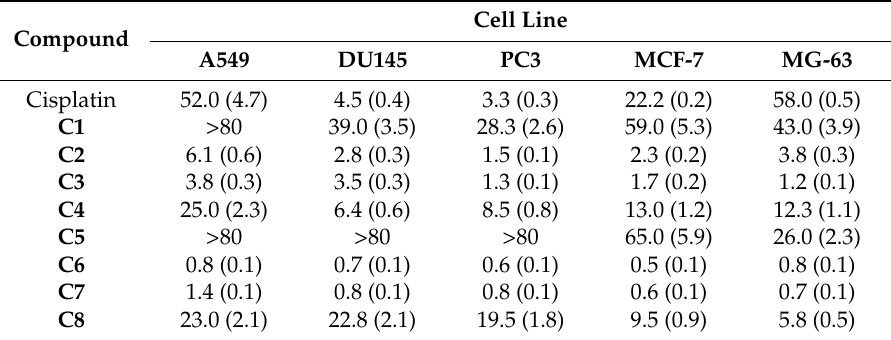
Table 1. Half-maximal inhibitory concentrations (IC 50 ) of cisplatin and new gold (III) compounds in human lung, prostate, breast, and osteosarcoma cancer cell lines. Values are mean (SD) expressed in µ M.